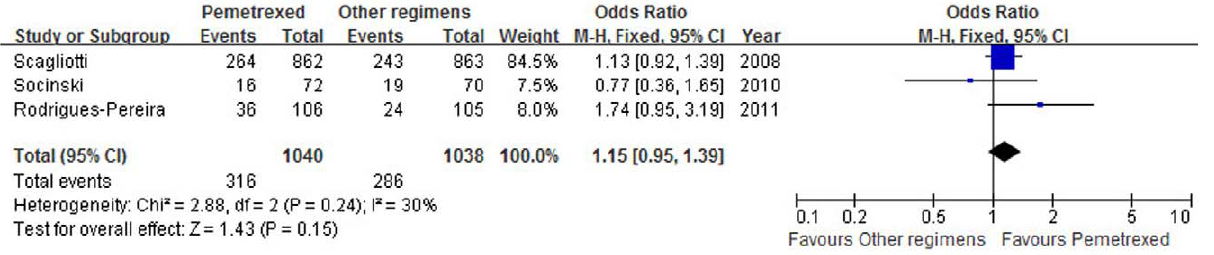
Figure 5. Comparison of response rate between pemetrexed plus platinum chemotherapy and other platinum-based regimens. Abbreviations: M-H, mantel-haenszel; CI, confidence interval.